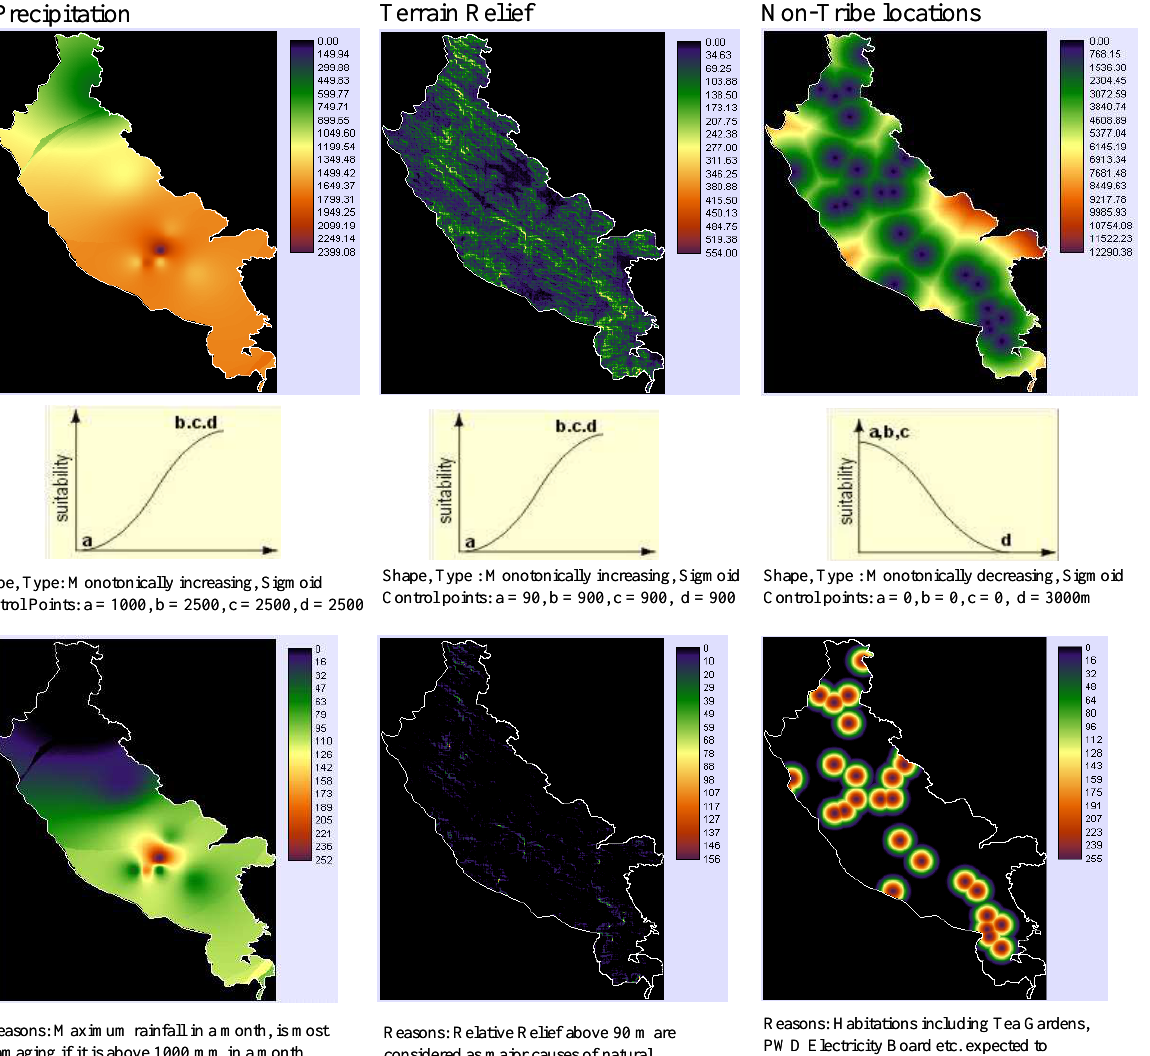
Figure 5. (b) List of potential spatial drivers (precipitation, terrain relief, locations of non- tribe) generated using multi-criteria decision support to generate suitability image for the evergreen forest change modelling of KMTR, South Western Ghats, Tamil Nadu,